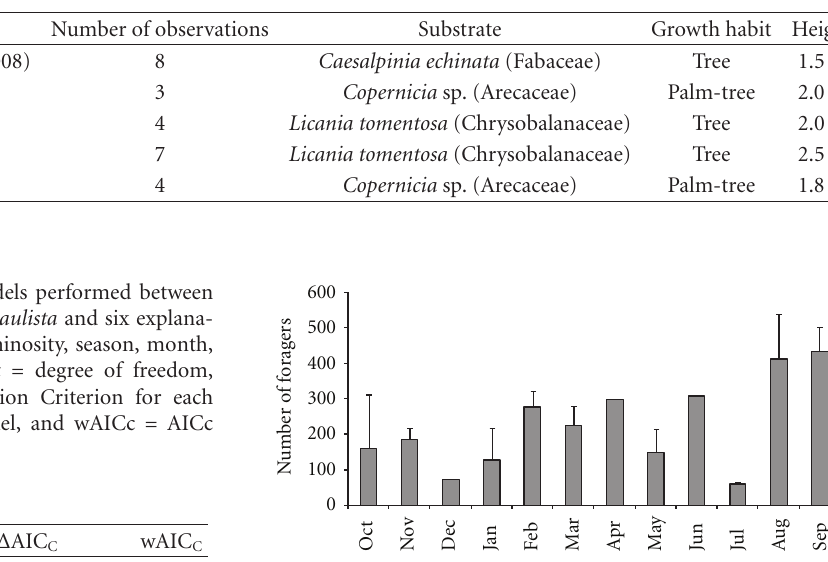
Table 1: Months in which each nest was sampled and the number of days that each nest was observed, as well as the substrates, growth habit, and height where the nests were found in the social wasp Polybia paulista .